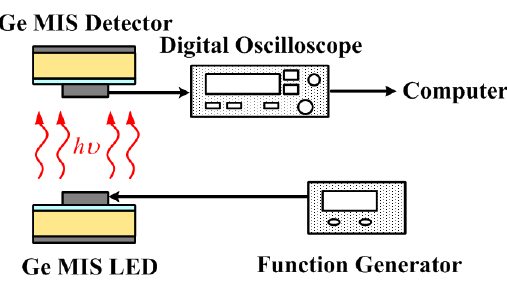
Figure 16. Data communication system using a Ge MIS photodetector and a Ge MIS LED. The same MIS structure was used with different biases for different applications. The Ge MIS structure with an inversion bias acted as a detector, while it acted as an LED with an accumulation bias [55].